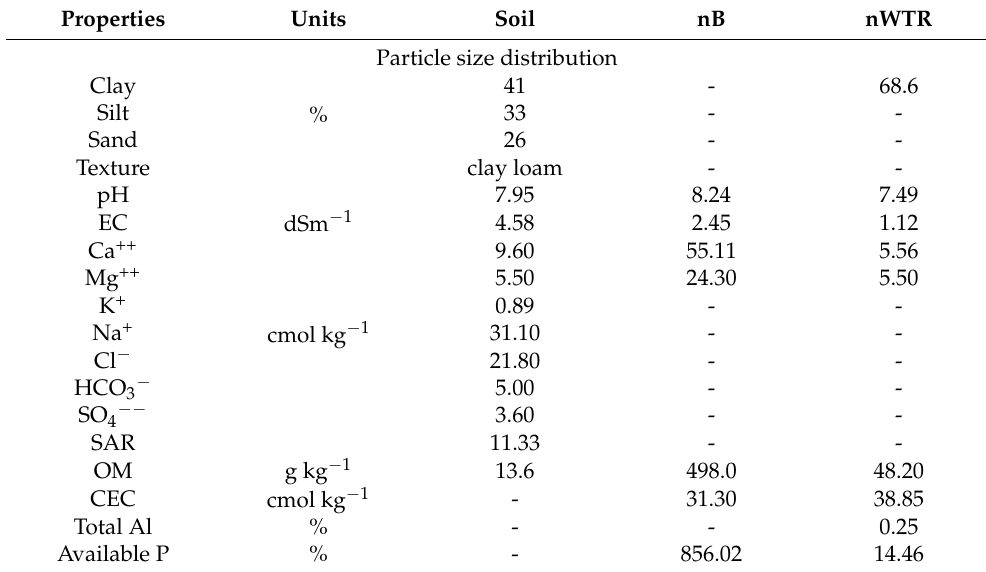
Table 1. Characteristics of soil, rice straw biochar (nB), and water treatment residuals (nWTR) used in the